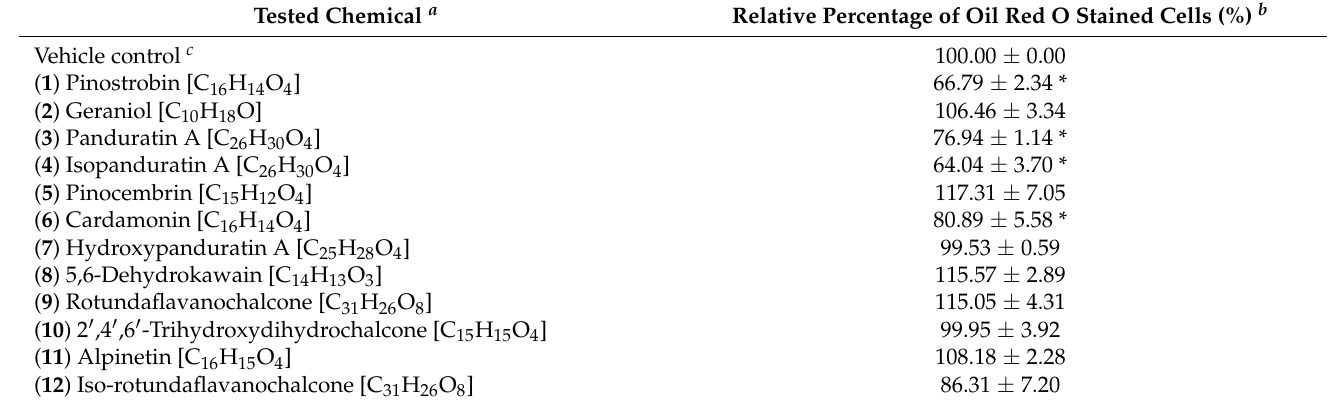
Table 2. List of phytochemicals from Boesenbergia rotunda roots and their effects on lipid content in 3T3-L1 cells determined by Oil Red O